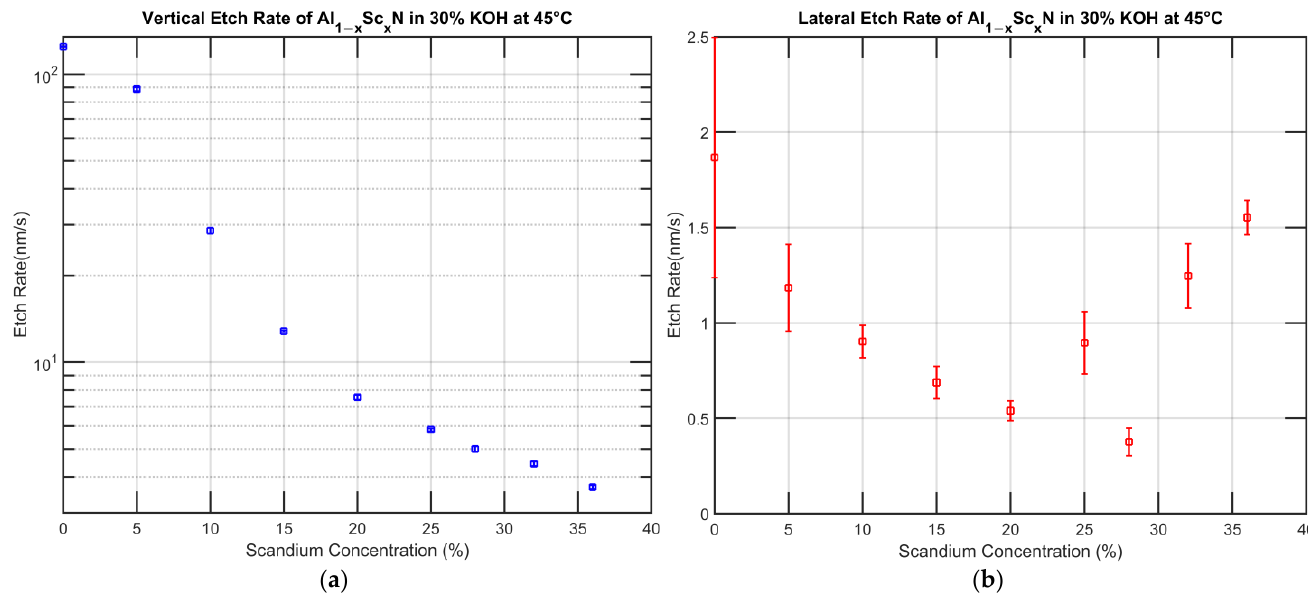
Figure 5. ( a ). Vertical etch rate of Al 1 − x Sc x N in 30% KOH at 45 °C. ( b ) Lateral etch rate of Al 1 − x Sc x N in 30% KOH at 45 °C (short etch time).